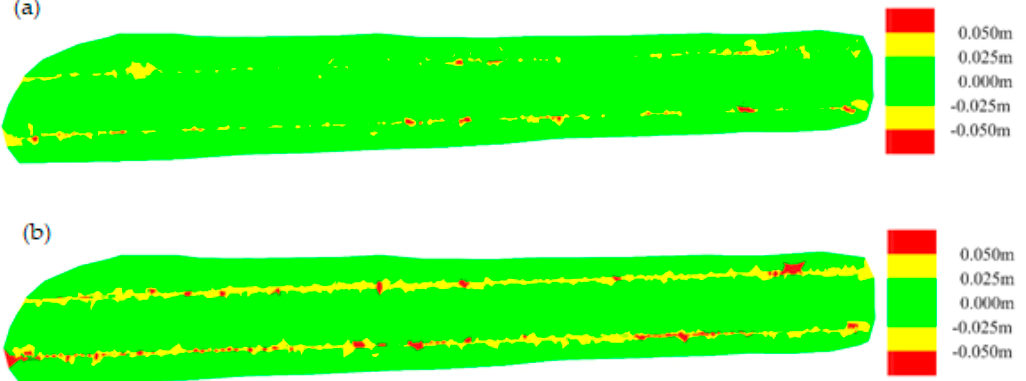
Figure 19. Spatial evaluation using elevation di ff erence surface: ( a ) proposed method versus manual method and ( b ) proposed method versus field survey Table 3. Di ff erence surfaces statistics